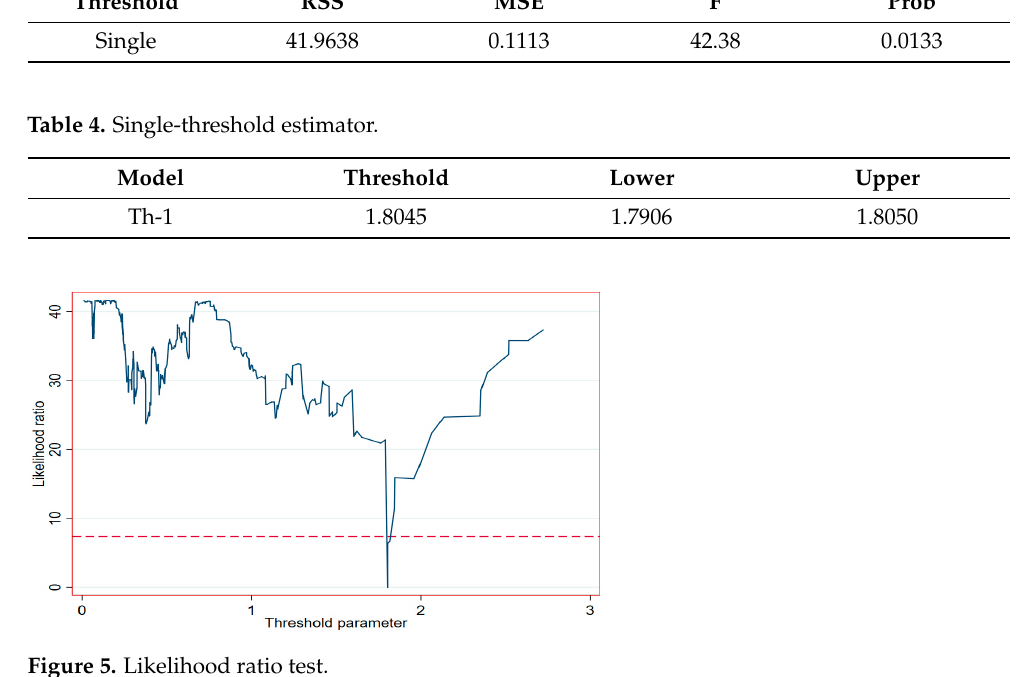
Table 3. Single-threshold effect test.